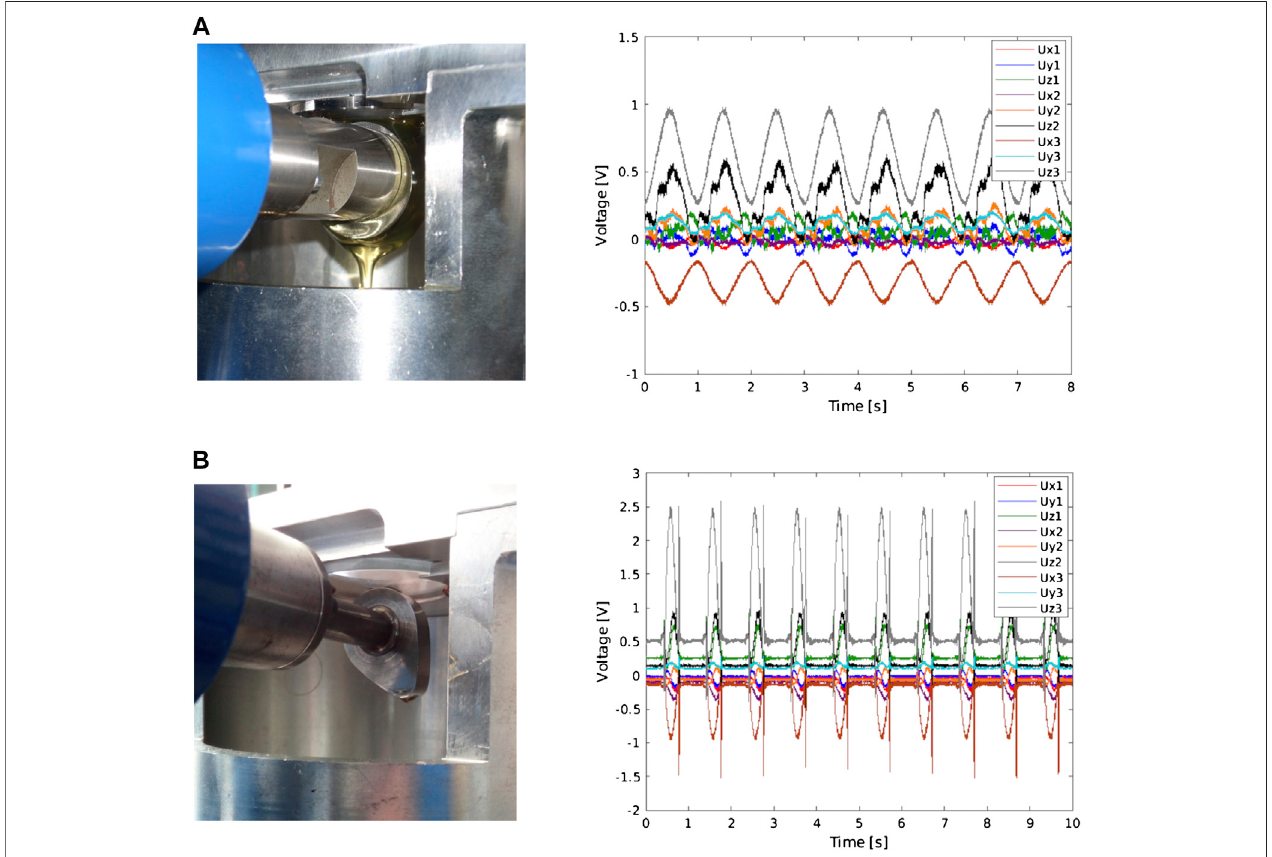
FIGURE8| Camsspecimensconnectedtotheshaftincontactwiththefollower(left)andsampledatarecordedduringtestsat60 rpm(right). (A) Circulareccentric cam. (B) Spline